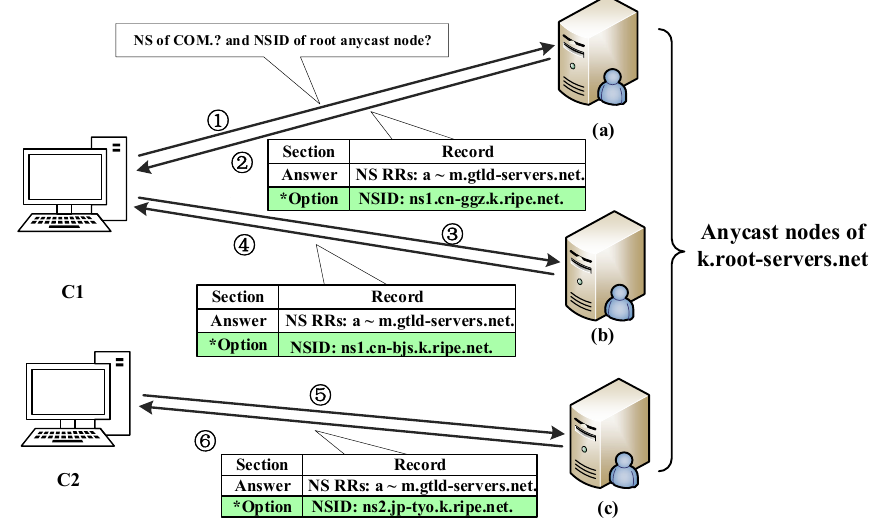
Figure 2. Example of obtaining the NS record of the top-level domain “com” and NSID of anycast nodes. The part marked with an asterisk is the NSID option, which identifies the mirror node from which this response comes.